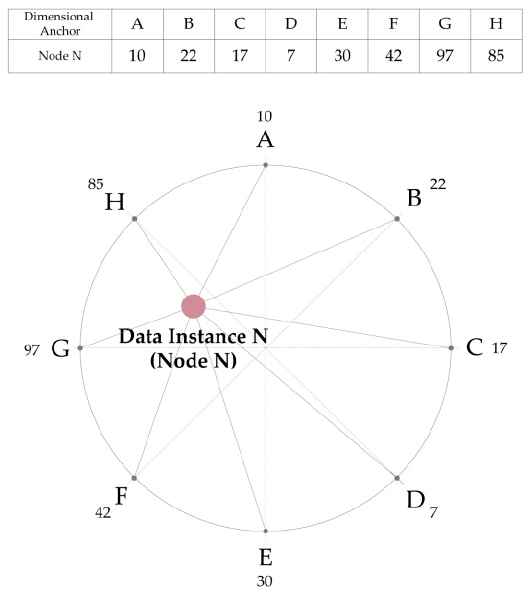
Figure 3. Principle of RadVis Visualization.